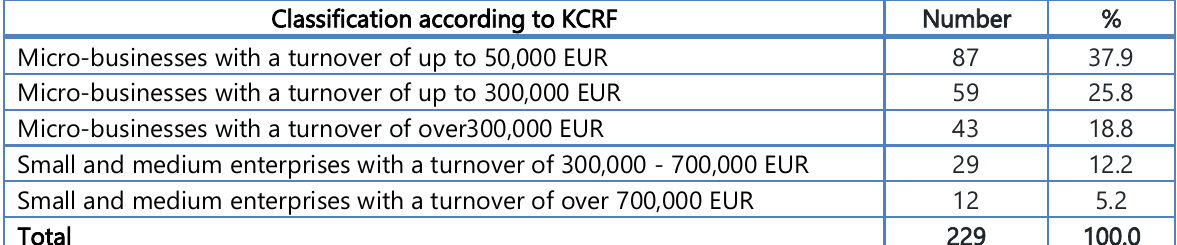
Table 1: A summary of sample stratification (Source: KBRA and TAK, 2020. Authors‟ Calculation) Classification according to KCRF Number